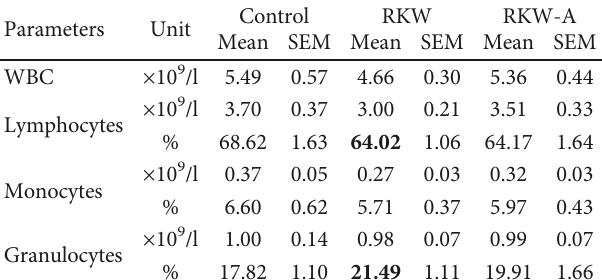
Table 2: Blood WBC analysis. Analysis was performed in the o ff spring of mothers fed during pregnancy and lactation with water (RKW) or hydroalcoholic (RKW-A) extract of Rhodiola kirilowii . Bold font indicates statistically signi fi cant di ff erences in comparison to control group ( P < 0 05 ).